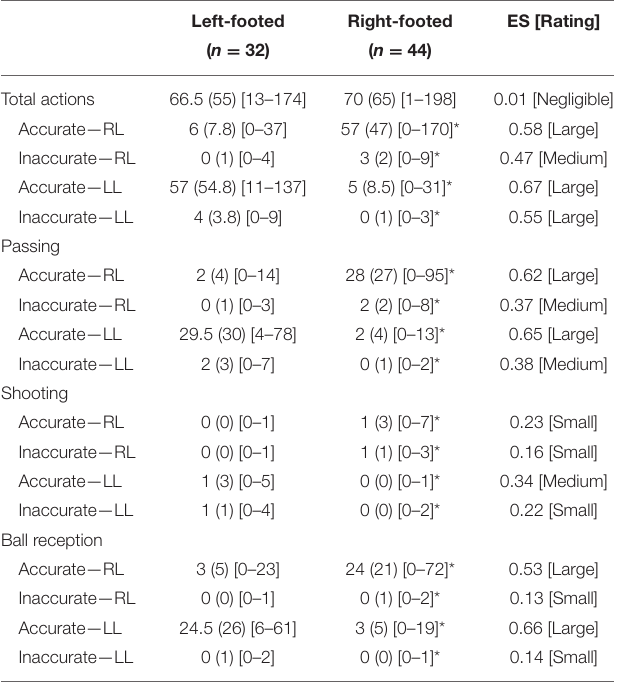
TABLE 2 | Median, interquartile range, and extreme values of frequency counts (absolute number; a.u.) of technical parameters presented by left-footed and right-footed players.